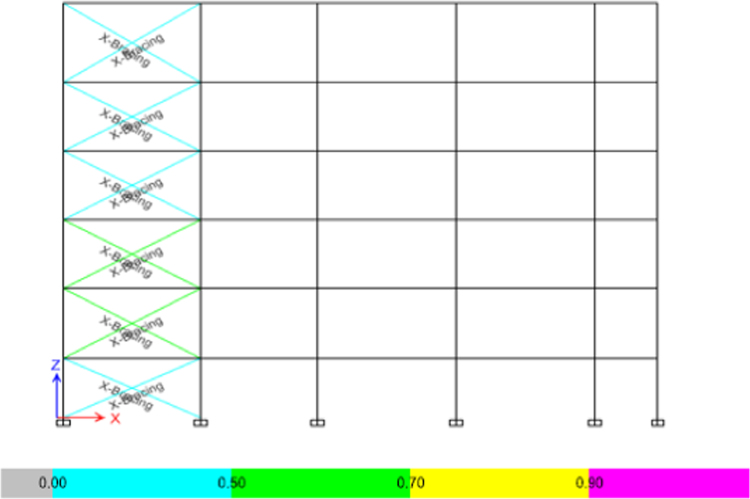
Steel bracing moment interaction capacity in the elevation view.